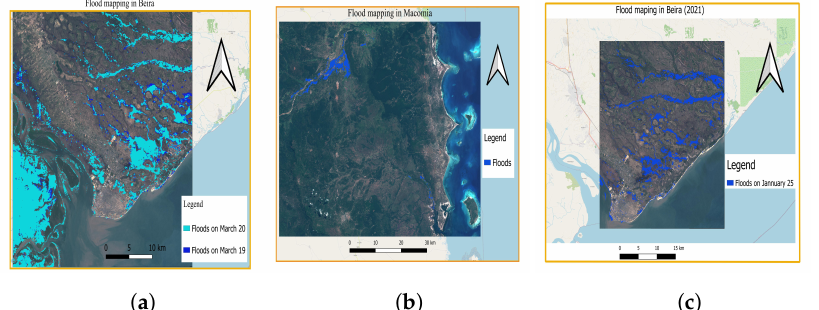
Figure 7. FM results for TCs Idai, Kenneth, and Eloise. ( a ) displays FM results for two consecutive days in Beira. It can be seen that on 20th the water tends to be receding. ( a ) TC Idai. ( b ) TC Kenneth. ( c ) TC Eloise. Table 5. Accuracy assessment results for FM in Beira, 19 and 20 March, and Macomia district 28 April both in